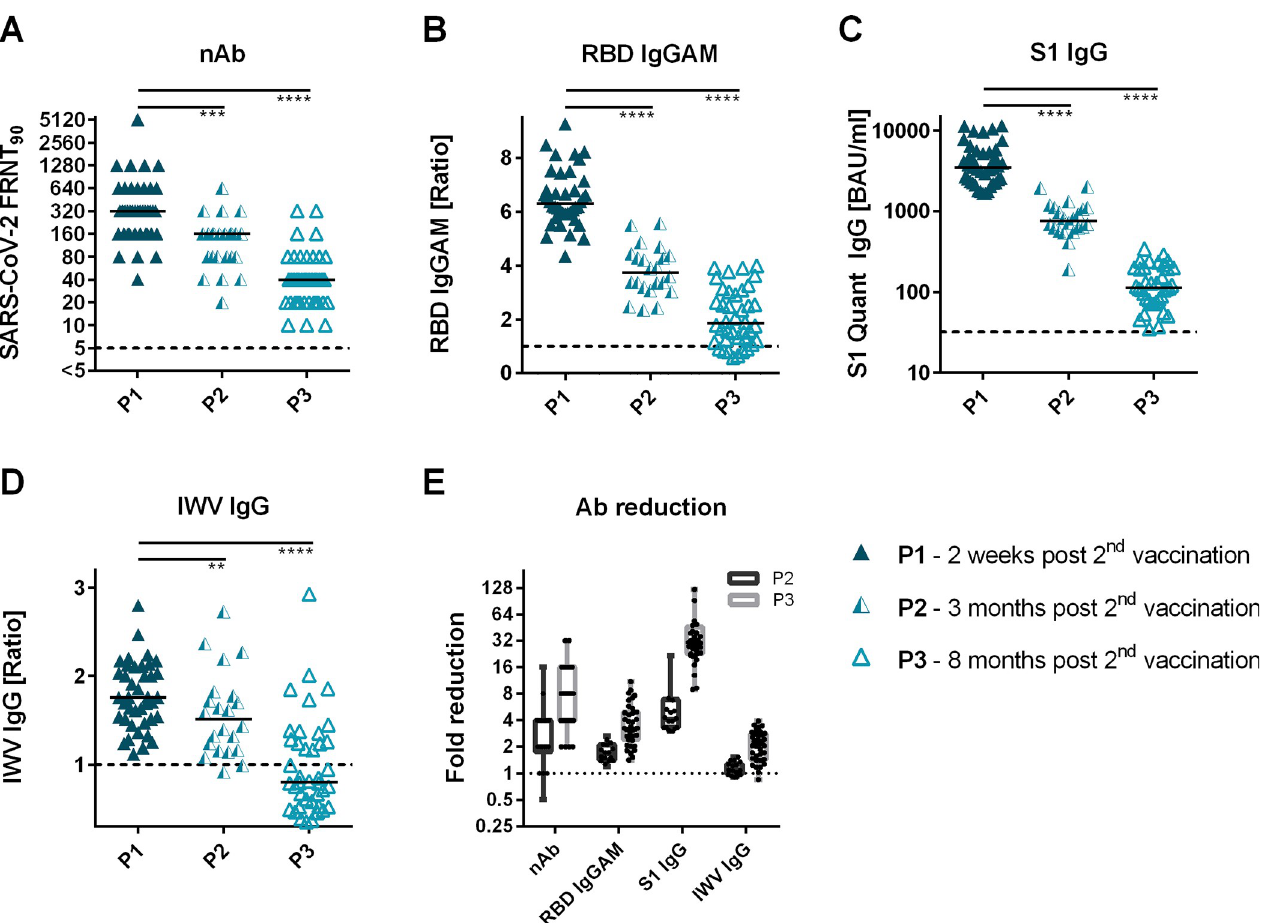
Fig 4. BNT162b2-induced antibody levels 2 weeks, 3 and 8 months after first vaccination. (A) Reciprocal titers of SARS-CoV-2 neutralizing antibodies were measured in focus reduction neutralization assay with inhibitor titer 90% (FRNT90). (B) RBD IgGAM signals were determined as sample/calibrator ratios (C) S1 IgG antibodies were quantitatively measured in binding antibody units per milliliter (BAU/ml). (D-E) S1 IgA and IWV (SARS-CoV-2 inactivated whole- virion) titers were determined as sample/calibrator ratios. (F) Fold reduction of SARS-CoV-2 neutralizing antibody titers, RBD IgGAM, S1 IgG, S1 IgA and IWV IgG antibody signals in follow-up vaccine sera calculated as ratio of value on timepoint P1 to timepoint P3.